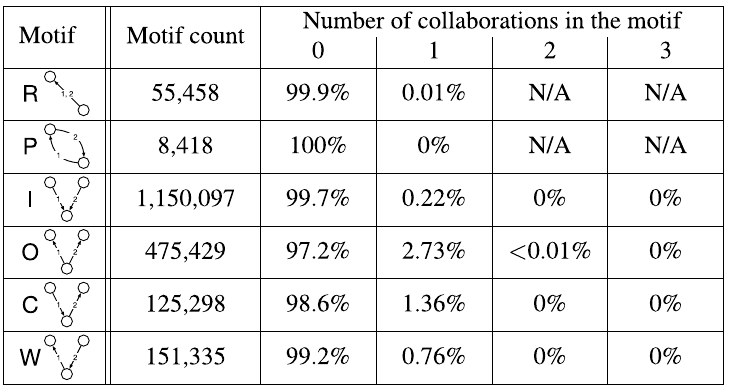
Table 4. The number of collaborations observed in each 2-event opposition motif. Here we show the total count of each motif and the fraction of the opposition motifs with 0, 1, 2, and 3 collaborations.